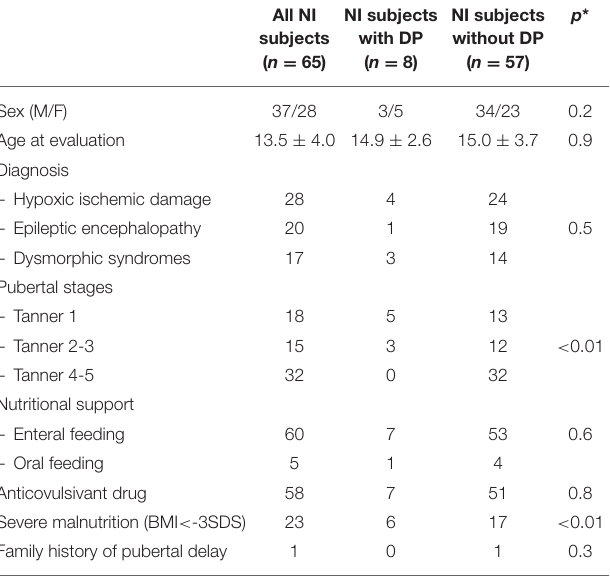
TABLE 1 | Clinical features of the NI